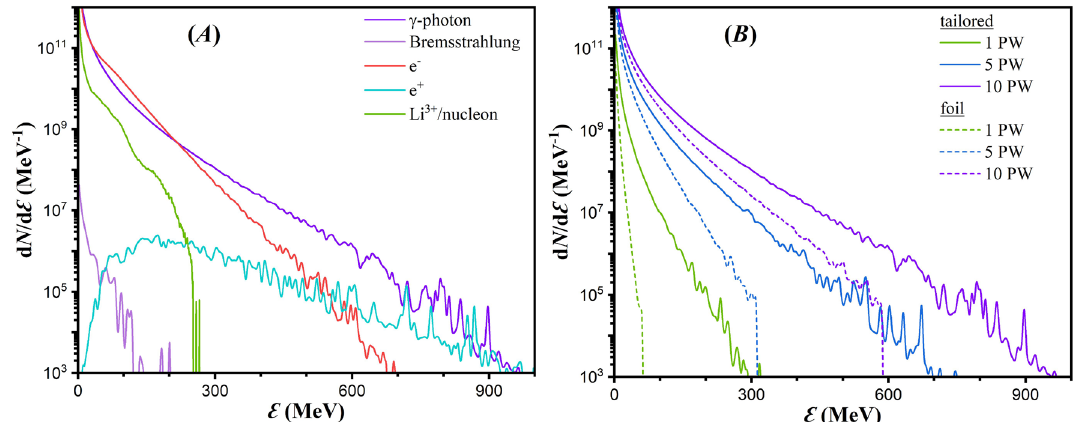
Figure 4. ( A ) Energy spectra after a 10PW laser interacts with a tailored lithium target. ( B ) Energy spectra of γ -photons after interaction of the main laser pulse (of power as indicated on the figure legend) with a lithium target, as noted on the legend. The solid lines correspond to tailored targets, and the dashed lines to foil